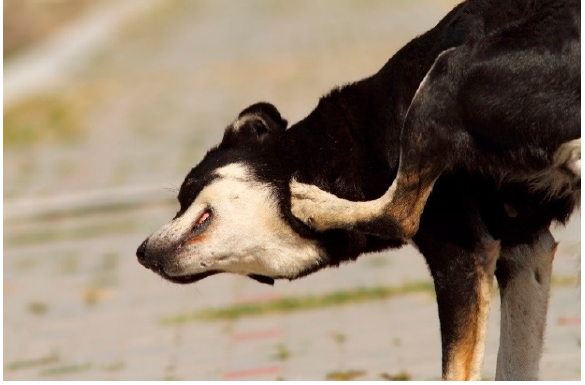
Figure 8. Source: Shutterstock 226564546.